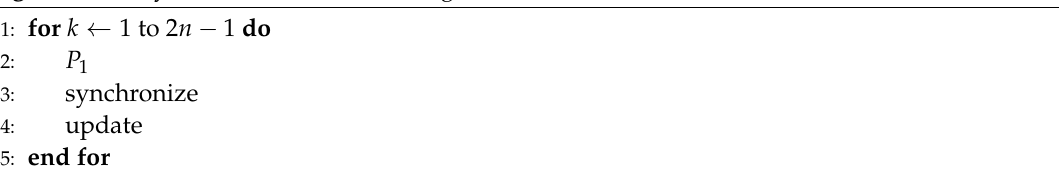
Algorithm 9 was executed on Blue Gene/P with up to 1024 cores. For the software side, the programming environment of MPI and the parallel C compiler, mpixlc, were used with Optimization Level